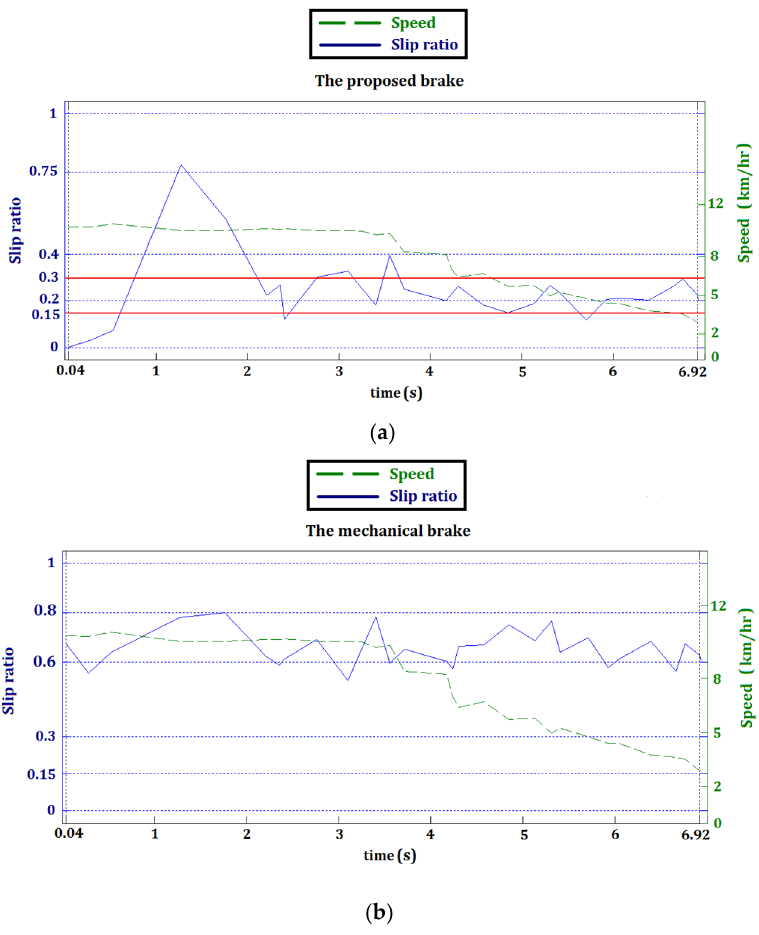
Figure 22. Comparison of the slip ratio of ( a ) the proposed brake and ( b ) the traditional mechanical brake on the TACX simulator.